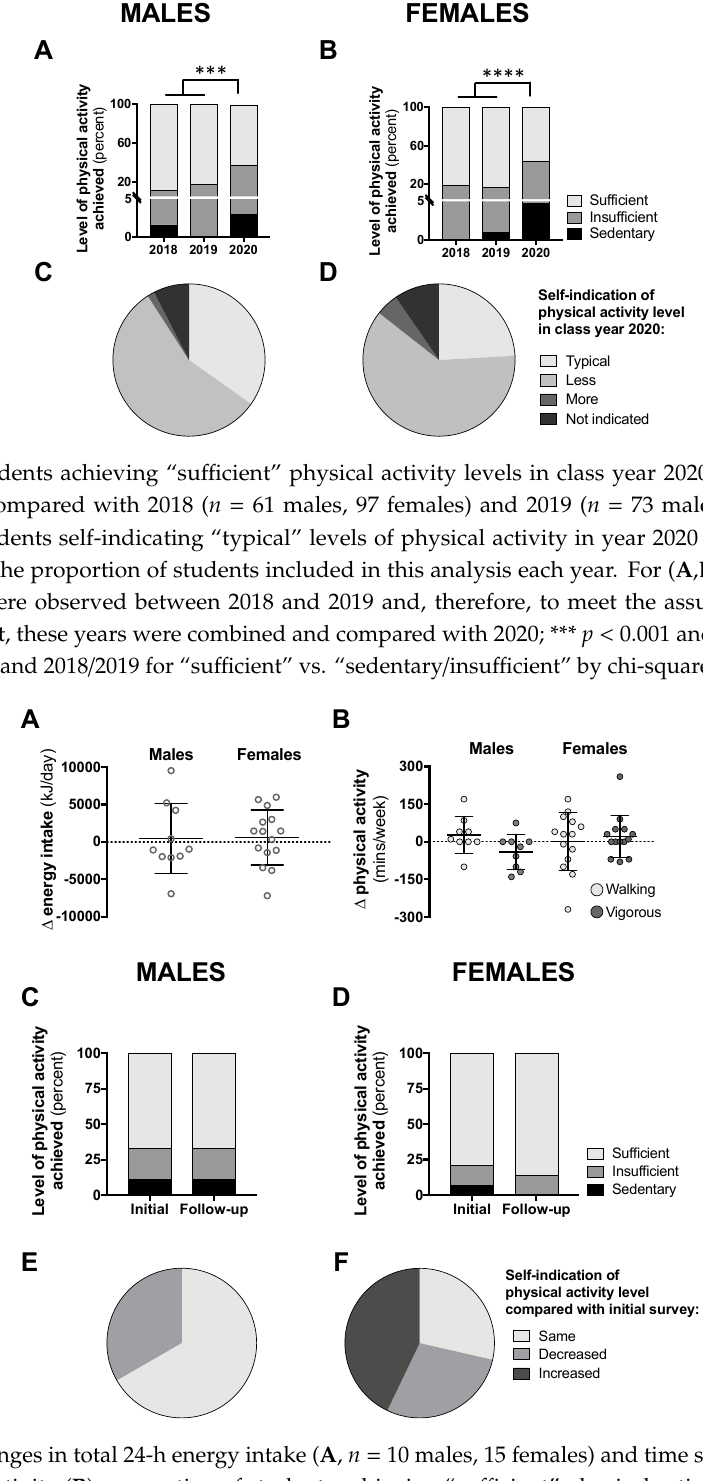
Figure 6. Changes in total 24-h energy intake ( A , n = 10 males, 15 females) and time spent in walking or vigorous activity ( B ), proportion of students achieving “sufficient” physical activity levels ( C , D ),